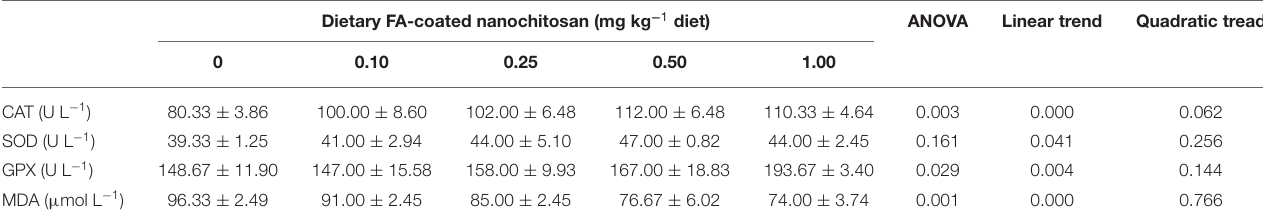
TABLE 4 | Antioxidant status of fingerling rainbow trout, Oncorhynchus mykiss , fed diets containing varying levels of folic acid coated nanochitosan*. Dietary FA-coated nanochitosan (mg kg − 1 diet) ANOVA Linear trend